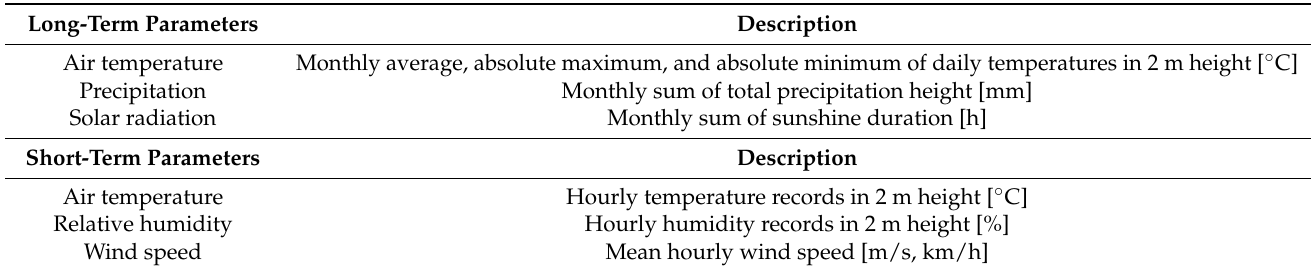
Table 1. Overview of selected parameters for long-term and short-term